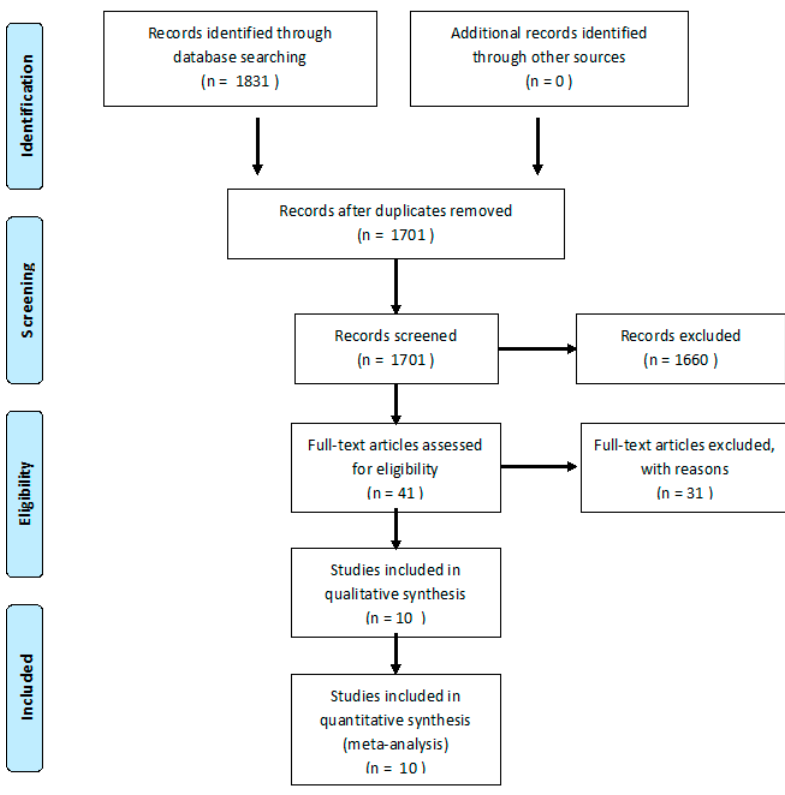
Figure 1. Flow diagram of the process of study selection.